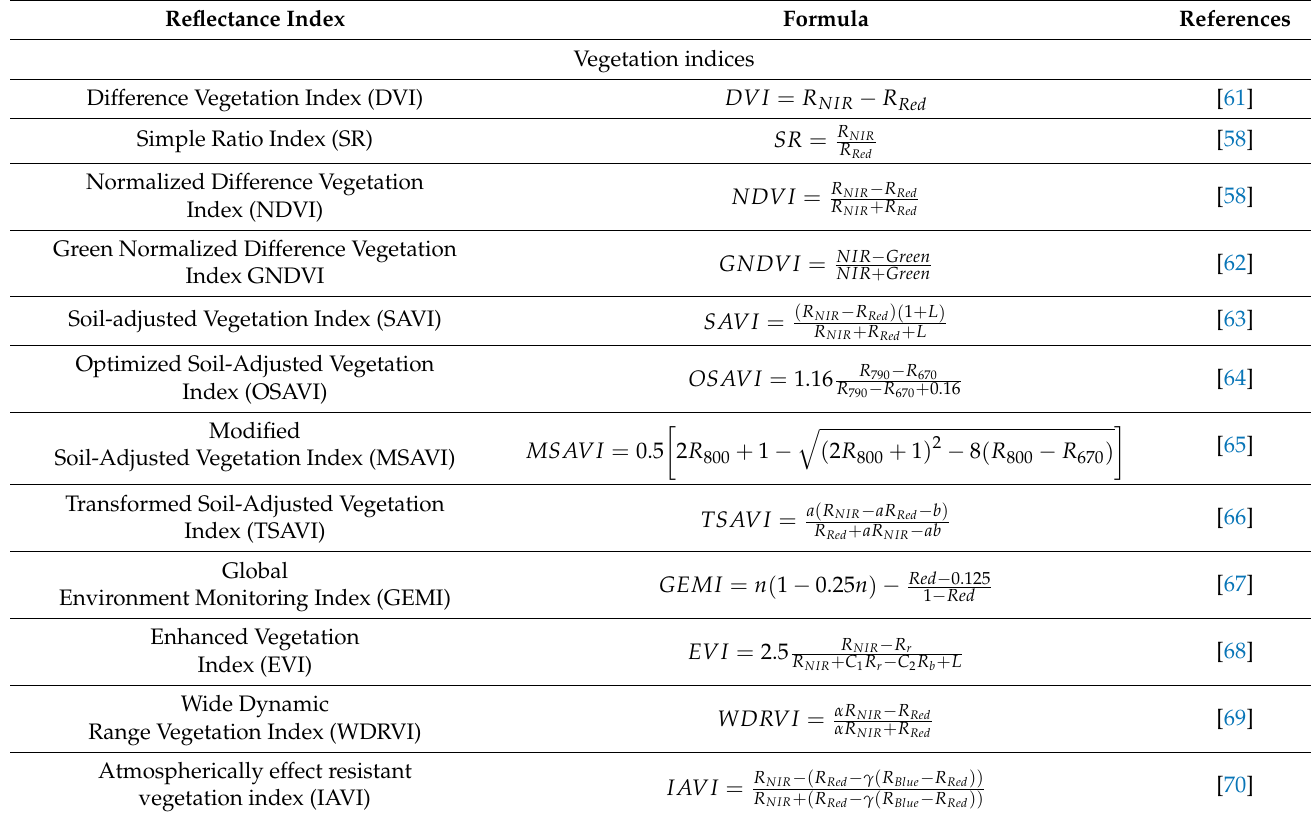
Table 1. Main reflectance indices used for the plant remote